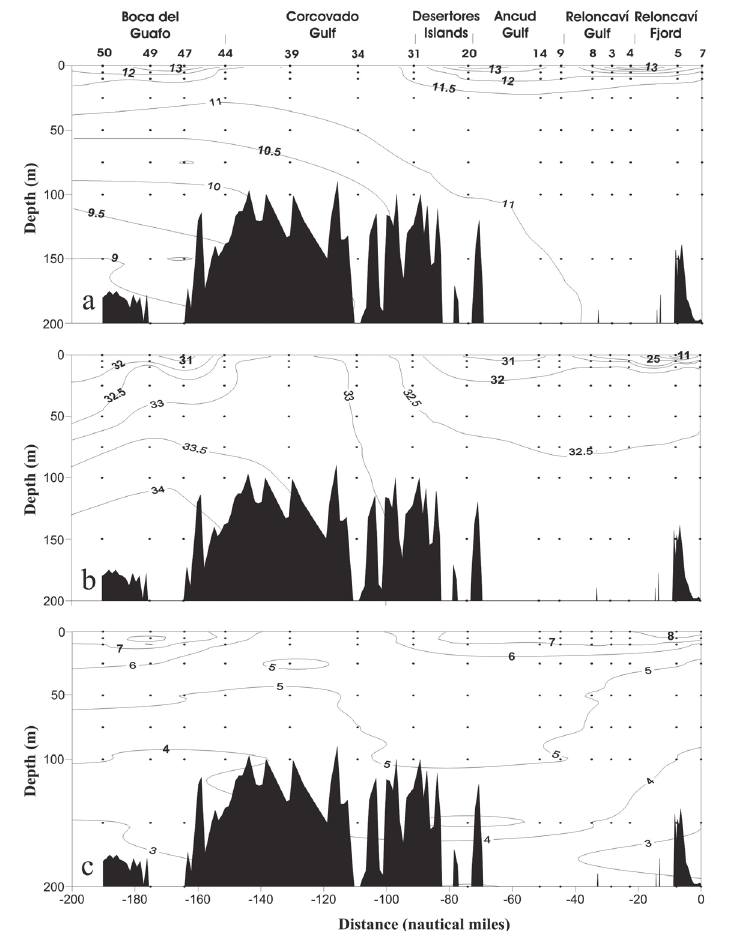
Fig . 2. – Longitudinal section of a) temperature (ºC), b) salinity, and c) dissolved oxygen (mL L -1 ).